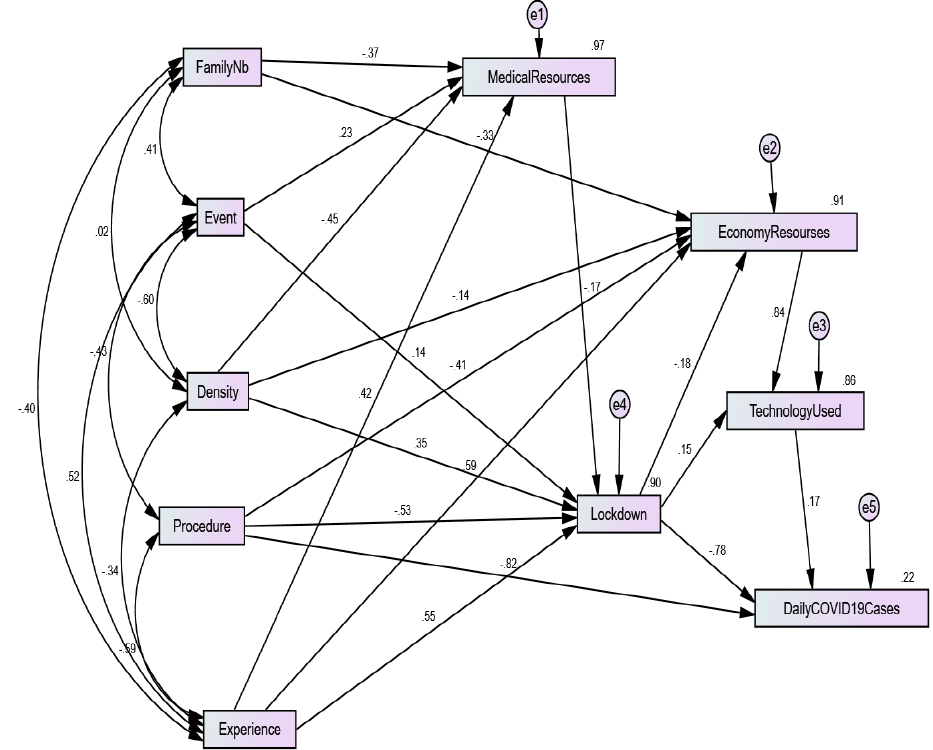
Figure 4. Path diagram of the default model with standardized parameter estimates .